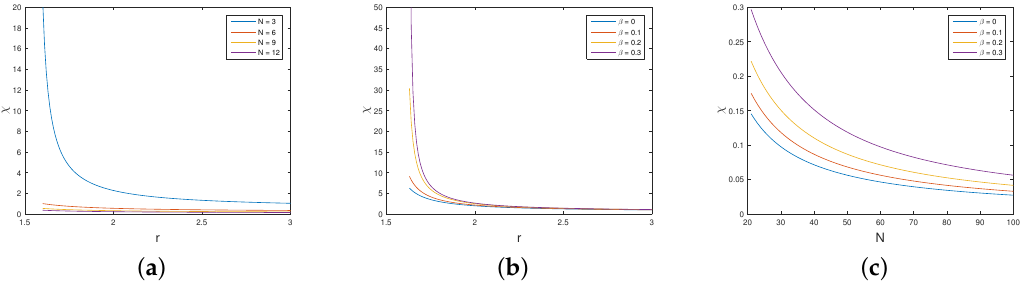
Figure 5. The upper bound of χ of the extortion strategy. ( a ) upper bound of χ vs. r ( β = 0.15); ( b ) upper bound of χ vs. r ( N = 3); ( c ) upper bound of χ vs. N ( r =